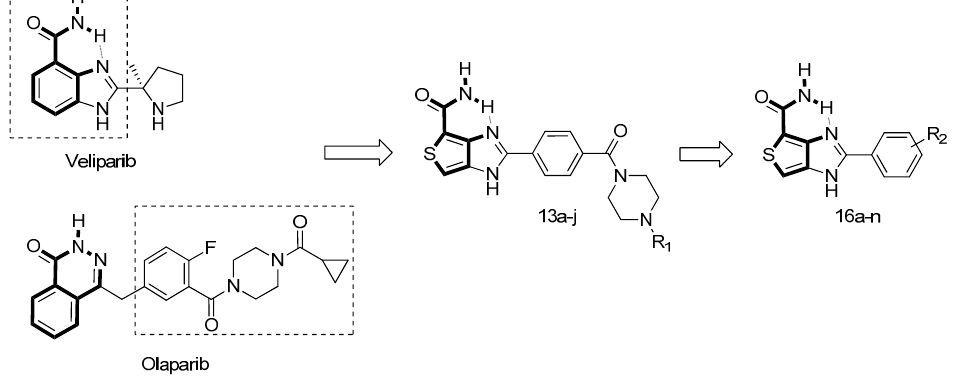
Figure 2. The design of novel PARP-1 inhibitors containing a thienoimidazole scaffold.